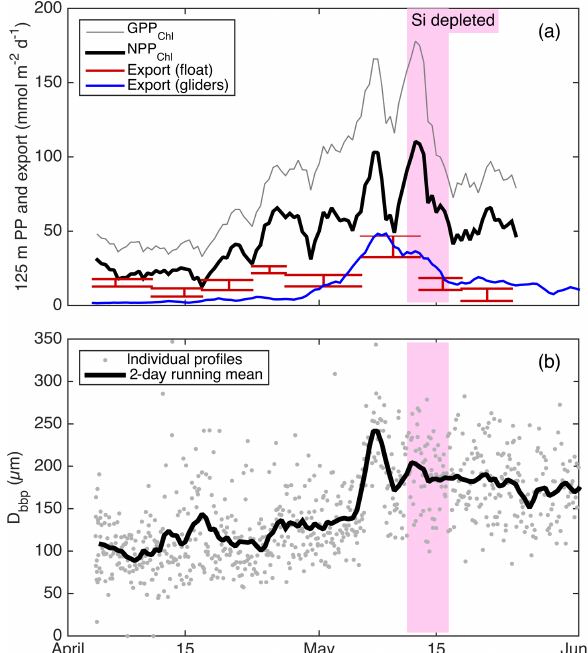
Figure 11. (a) Continuous productivity and export from the au- tonomous float and gliders to and from the top 125m over the en- tire study period. Productivity and glider export are 2-day running means, while float export is averaged over longer periods denoted by the width of the bars. Bar height denotes uncertainty bounds. (b) Near-surface glider D bbp estimates from